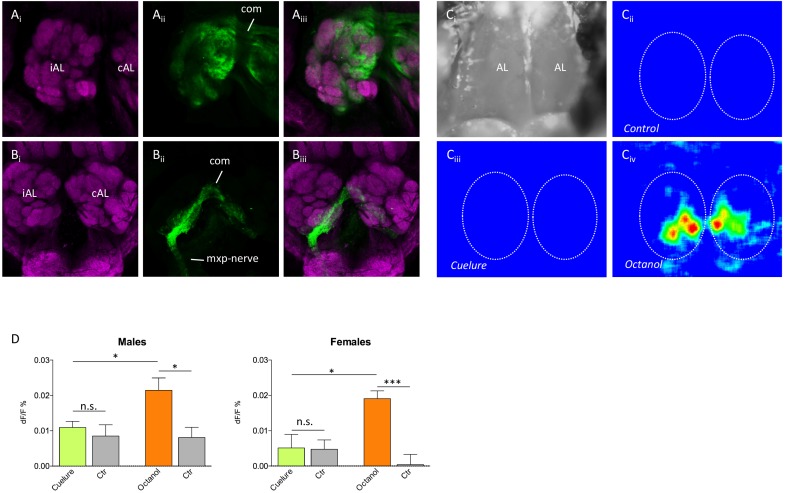
Antennal lobe innervation and odor-evoked activity. Tracing of (Ai–Aiii) antennal and (Bi–Biii) maxillary palp innervation in the antennal lobe (magenta, anti-synapsin staining; green, neurobiotin tracing). The iAL (ipsilateral) is the antennal lobe on the same side as the traced nerve, whereas the cAL (contralateral) only receives innervation via the commissure (com). Maxillary palp nerves (mxp-nerve) only innervate four to five glomeruli in the ventromedial part of both lobes, whereas antennal nerves innervate the remaining about 50 glomeruli. (Ci–Civ) False color coded Ca2+ imaging responses to control, cuelure, and octanol, respectively. Panel (Ci) shows a grayscale image of the area of the brain recorded from, while panels (Cii–Civ) show the relative change in activity (dF/F) during stimulation in a single male individual. In panels (Cii–Civ), the outlines of the antennal lobes are depicted by the dotted lines. The responses in panels (Cii–Civ) have identical intensity scales. (D) Mean ± SEM of the relative change in activity during odor stimulation. For cuelure and octanol, the response in the strongest activated glomerulus was used and compared with a solvent control response (paraffin oil). n.s., not significant, ∗P < 0.05, ∗∗∗P < 0.001 (unpaired t-test).